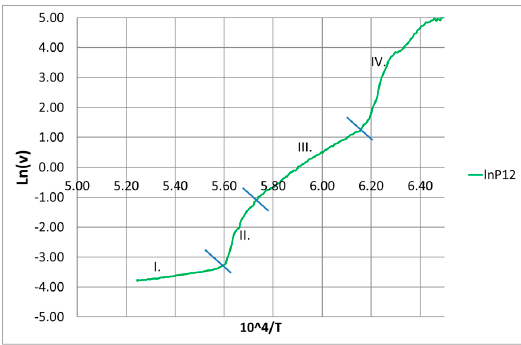
Figure 7. Arrhenius plot of viscosity of slag P12.